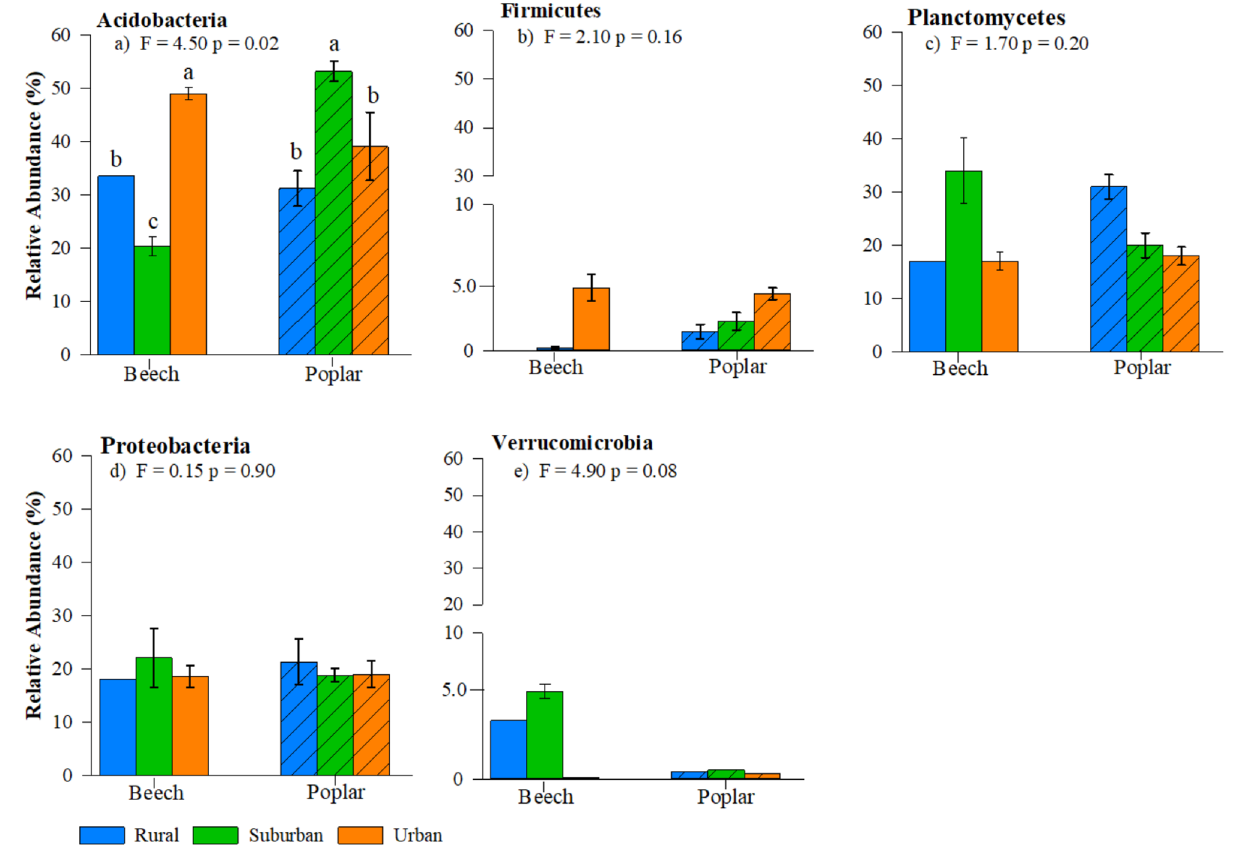
Figure 4. Relative abundance (%) of the dominate16S rRNA gene sequences isolated from microbial community members at the phylum level (mean + standard error) significantly influencing observed differences in NMDS plots along forest edges. Samples are separated by forest type: urban (orange) suburban (green) and rural (blue) and tree (column pattern). Significant differences are depicted when letters above the bars are different ( p <